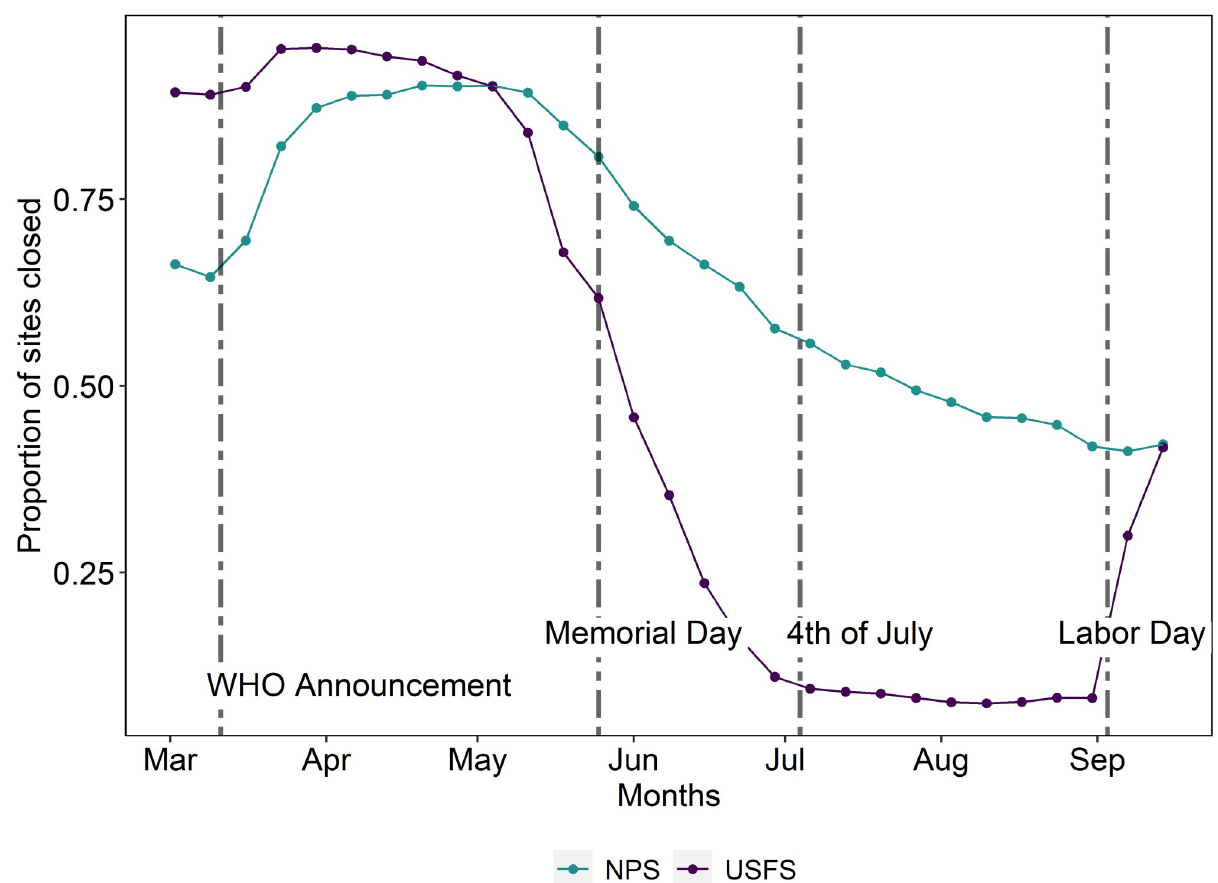
Fig 3. Proportion of USFS and NP campgrounds closed by week in